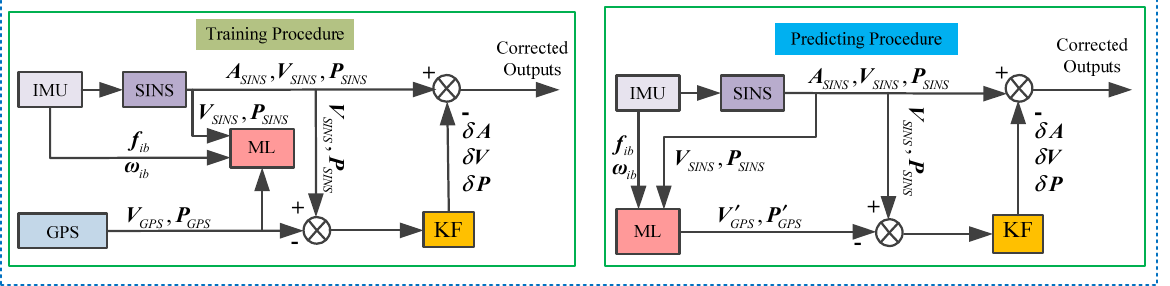
Figure 1. Schematic diagram of ML-aided SINS/GPS integrated navigation systems. ML is a machine learning module; KF is a Kalman filtering module; A SINS , V SINS , and P SINS are the SINS’ attitude, speed, and position, respectively; V GPS and P GPS are the GPS’ speed and position, respectively; and V (cid:48) GPS and P (cid:48) GPS are the speed and position of pseudo GPS information forecasted using the ML method, respectively.